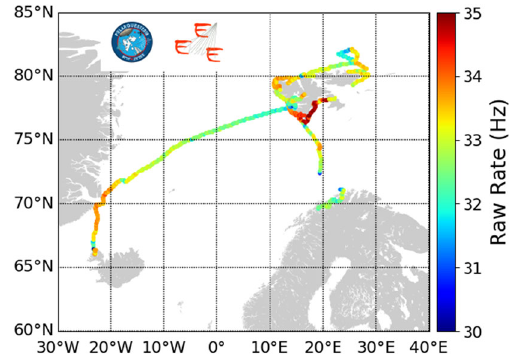
Fig. 17 Raw rate map measured by POLA-01 during its trip in the Arctic